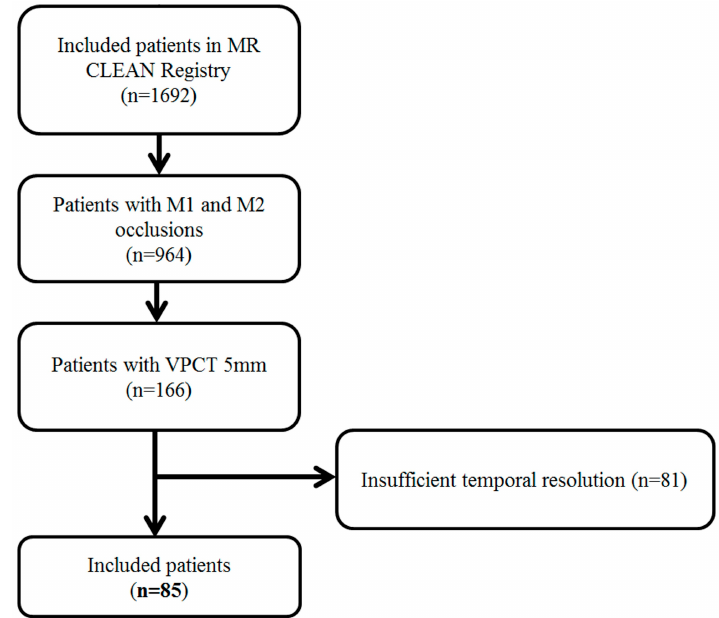
Figure 2. Flowchart of patient inclusion in the study.